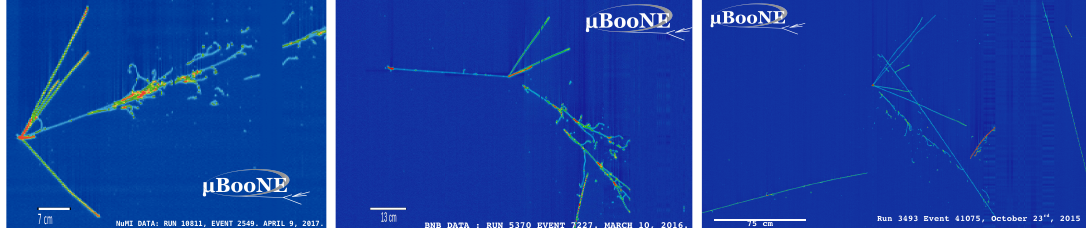
Figure 2. TITUS displays of neutrino candidate interactions with matter as recorded by the MicroBooNE experiment